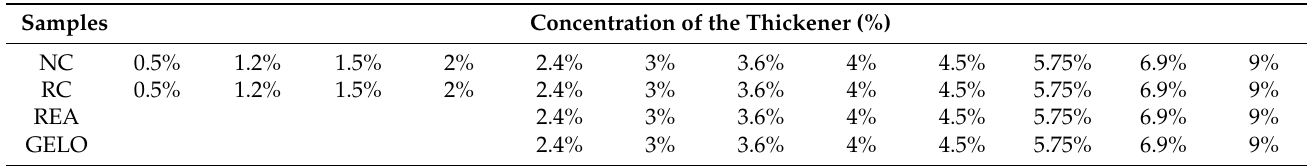
Table 1. Concentrations of thickeners made with